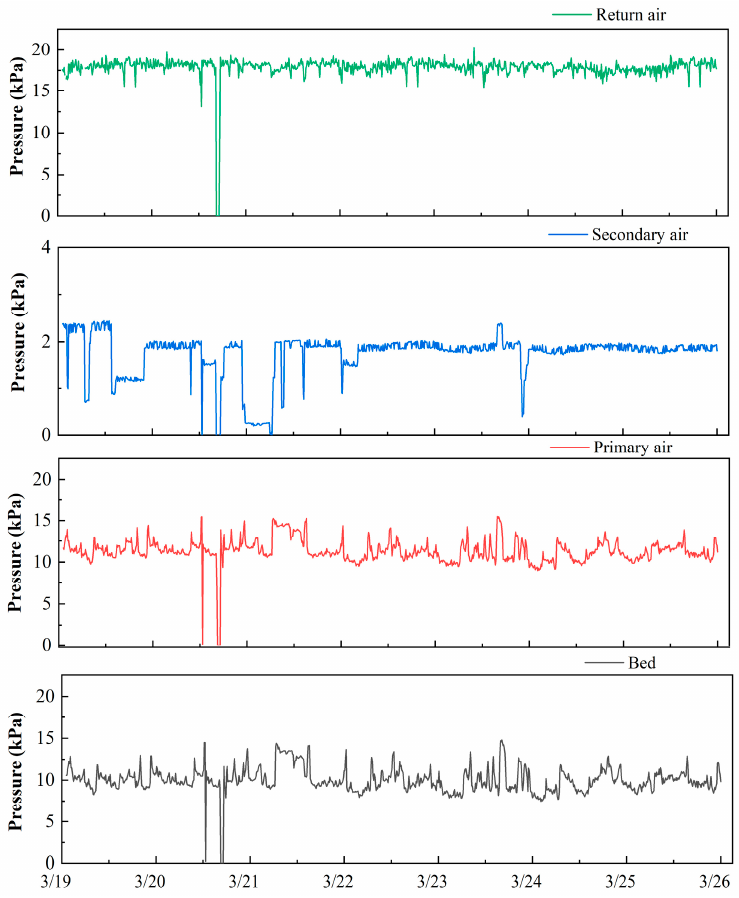
Figure 7. The trend for the pressure of the bed, primary air, secondary air, and return